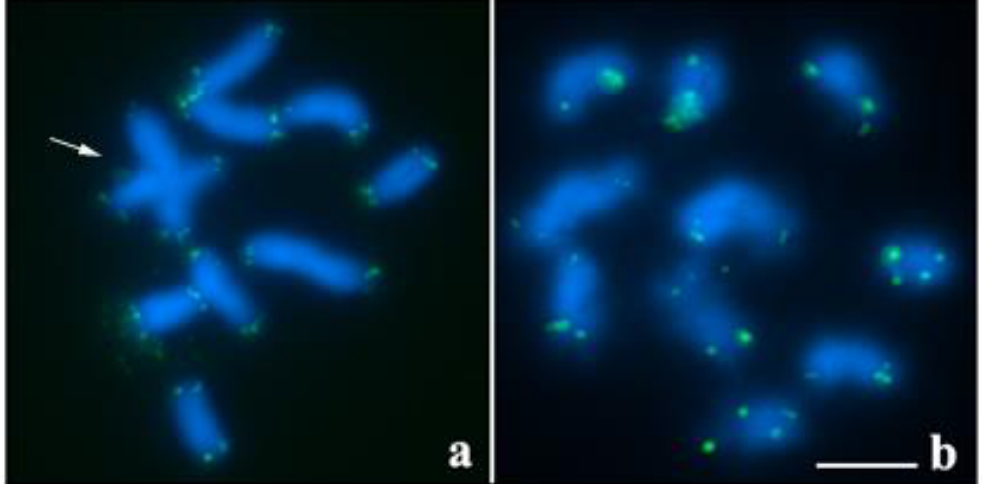
Figure 1. FISH with telomeric probe in meiotic chromosome of T. maranhensis (blue: DAPI; green: telomeres): ( a ) metaphase I (arrow indicates quadrivalent); ( b ) metaphase II. Bar: 10 µm.